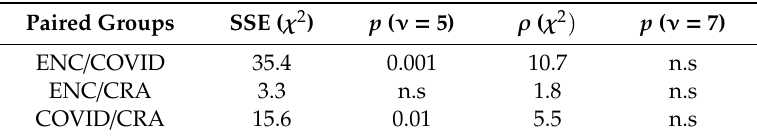
Table 2. Comparison by paired groups of patients for Shannon’s spectral entropy (SSE) and ρ using χ 2 . Statistical significance for either 5 (SSE) or 7 ( ρ ) degrees of freedom ( ν ) is indicated by p in column to the right of every variable.